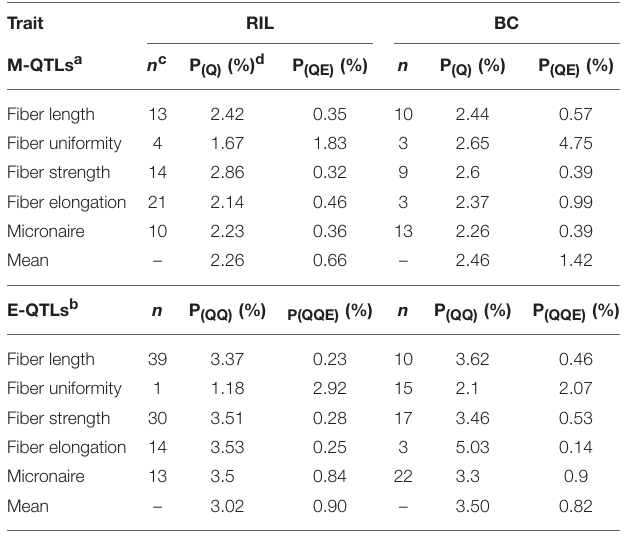
TABLE 5 | Summary of M-QTLs and E-QTLs by environment interaction controlling fiber quality traits by inclusive composite interval mapping in RIL and maternal BC population.